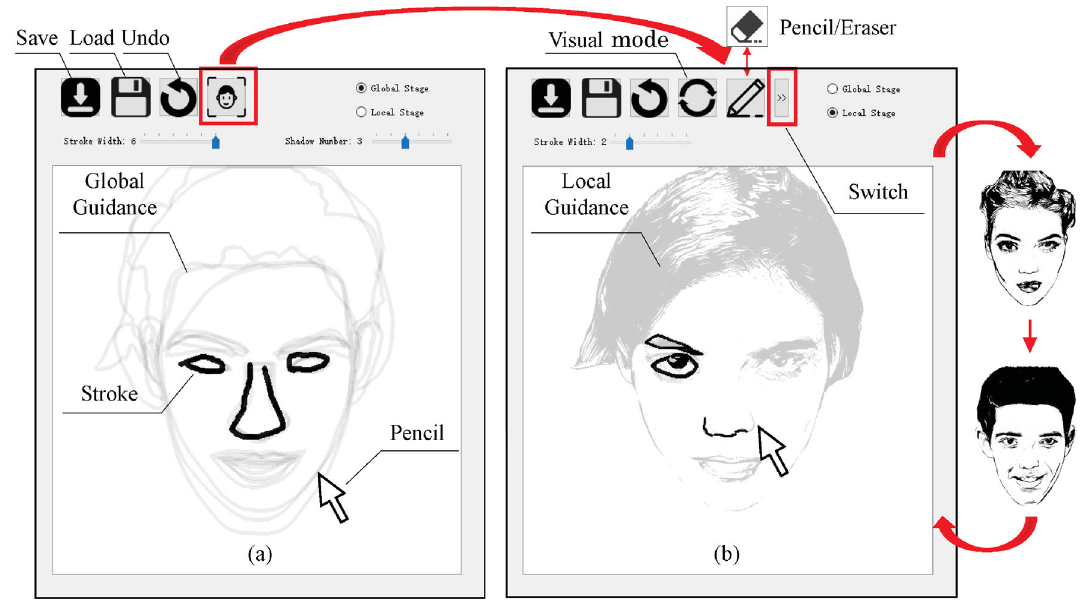
Fig. 2 Our two-stage guidance system. Given a user’s intermediate drawing at runtime, the system generates: (a) global guidance by blending relevant images from the database and (b) local guidance (i.e., realistic facial portraits) using a model-based